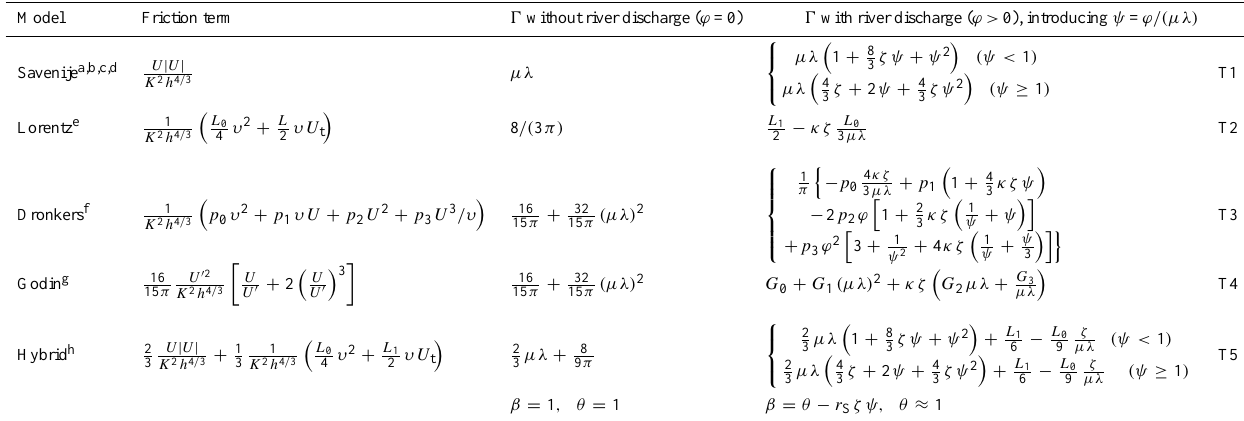
Table 3. Comparison of the terms in the damping Eq. (11) for different analytical methods. The effect of the time-dependent depth in the friction term for Lorentz’s, Dronkers’ and Godin’s method is accounted for by setting κ =1 in the expressions for 0 , whereas κ =0 describes the time-independent case. Model Friction term 0 without river discharge ( ϕ =0) 0 with river discharge ( ϕ > 0), introducing ψ = ϕ/(µλ) Savenije a,b,c,d U | U | K 2 h 4 /